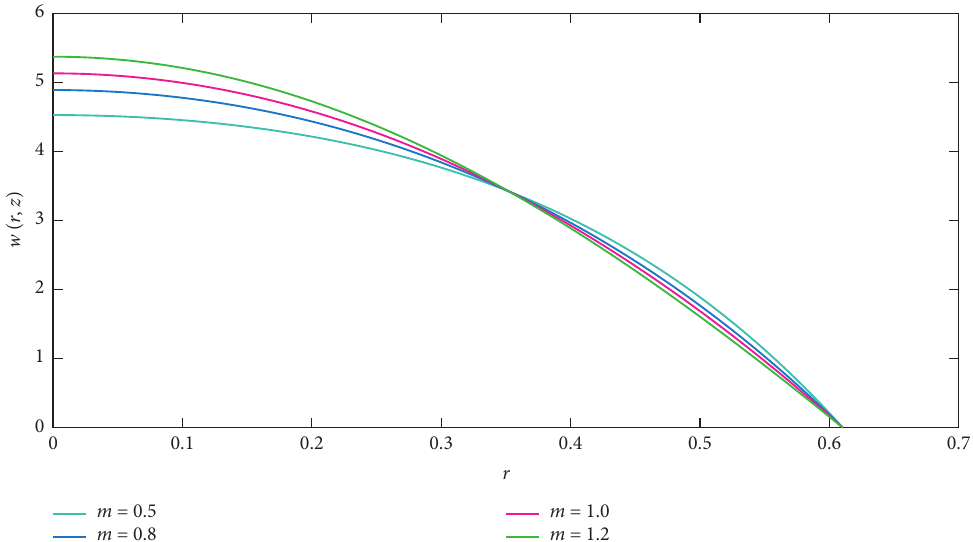
Figure 7: Velocity variation for the Carreau model for n � 3 ,L � 1 ,F � 3 , andWe � 0 . 1.